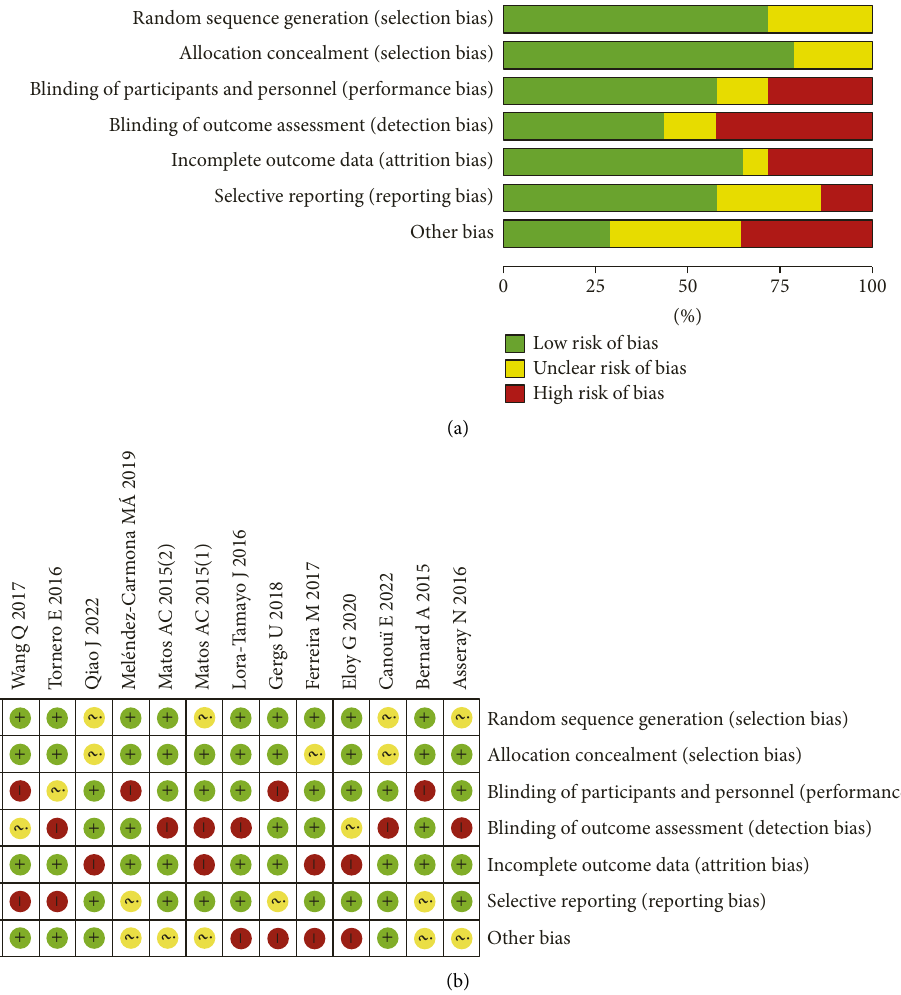
Figure 2: Literature quality evaluation chart. (a) Risk of bias graph. (b) Risk of bias